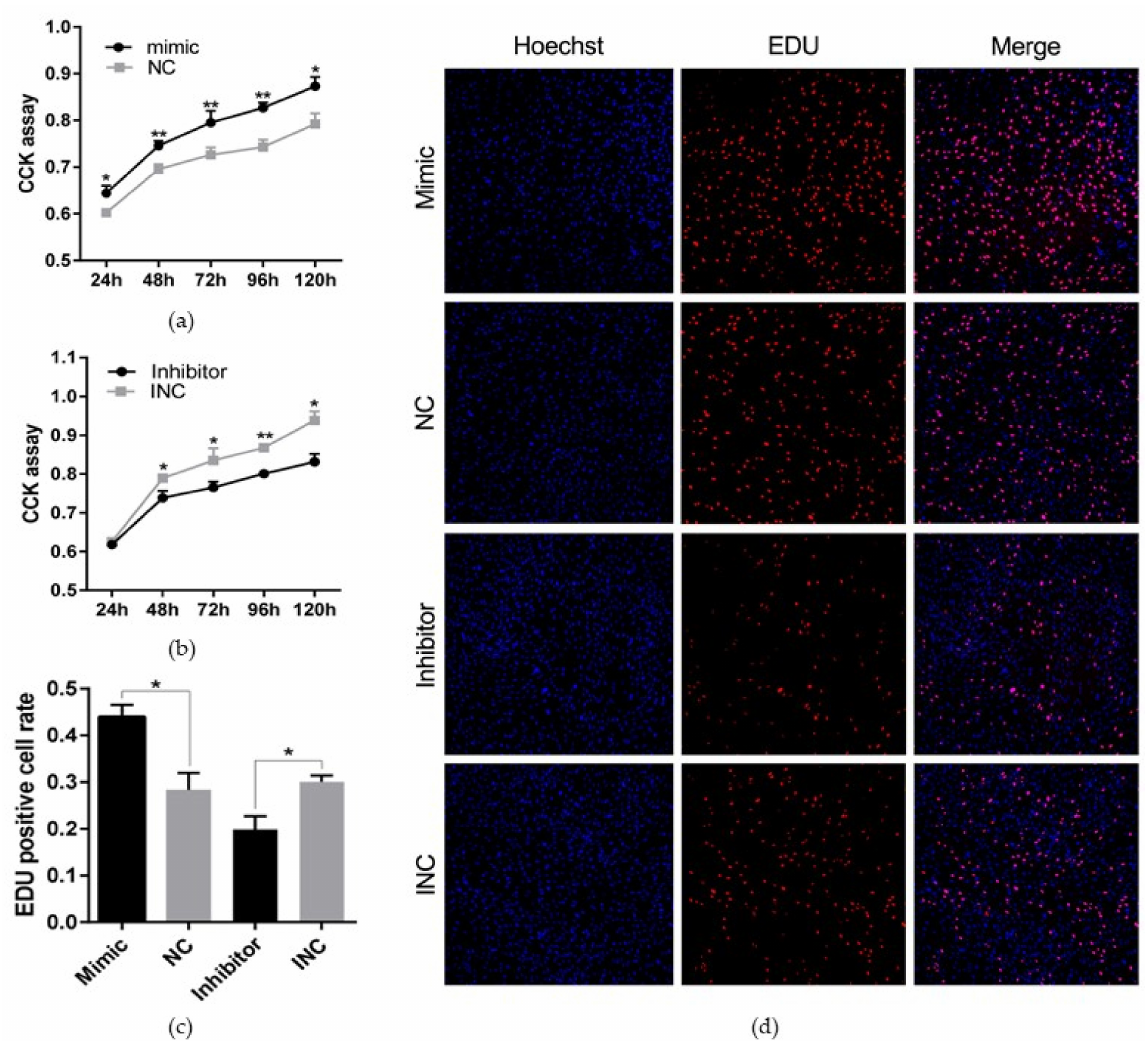
Figure 3. miR-208b promotes rabbit preadipocyte proliferation. ( a , b ) The absorbance of preadipocyte at 24, 48, 72, 96, and 120 h after transfection with the miR-208b mimic, NC, miR-208b inhibitor, and INC ( n = 6). ( c ) The percent of EDU positive cells. Red fluorescence represents the EDU positive cells, and blue fluorescence represents the Hoechst stained cells. EDU positive cells rate = EDU positive cells/Hoechst stained cells × 100% ( n = 3). ( d ) The picture of the EDU proliferation assay for preadipocyte transfected with the miR-208b mimic, NC, miR-208b inhibitor, and INC (red fluorescence represents EDU positive cells and nuclei are indicated by blue fluorescence). The data are presented as means ± SEM. * p < 0.05; ** p <